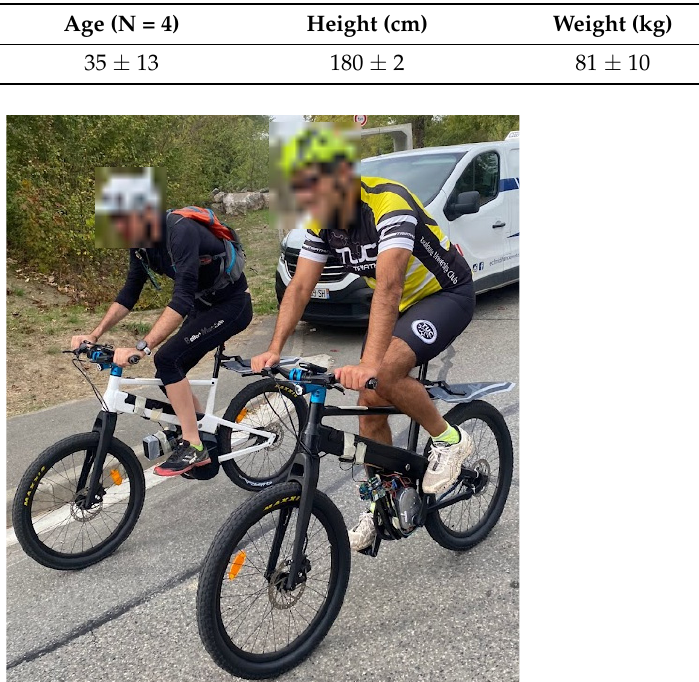
Figure 9. Example photo of participants performing a test. Table 4. Participants’ average physiology.